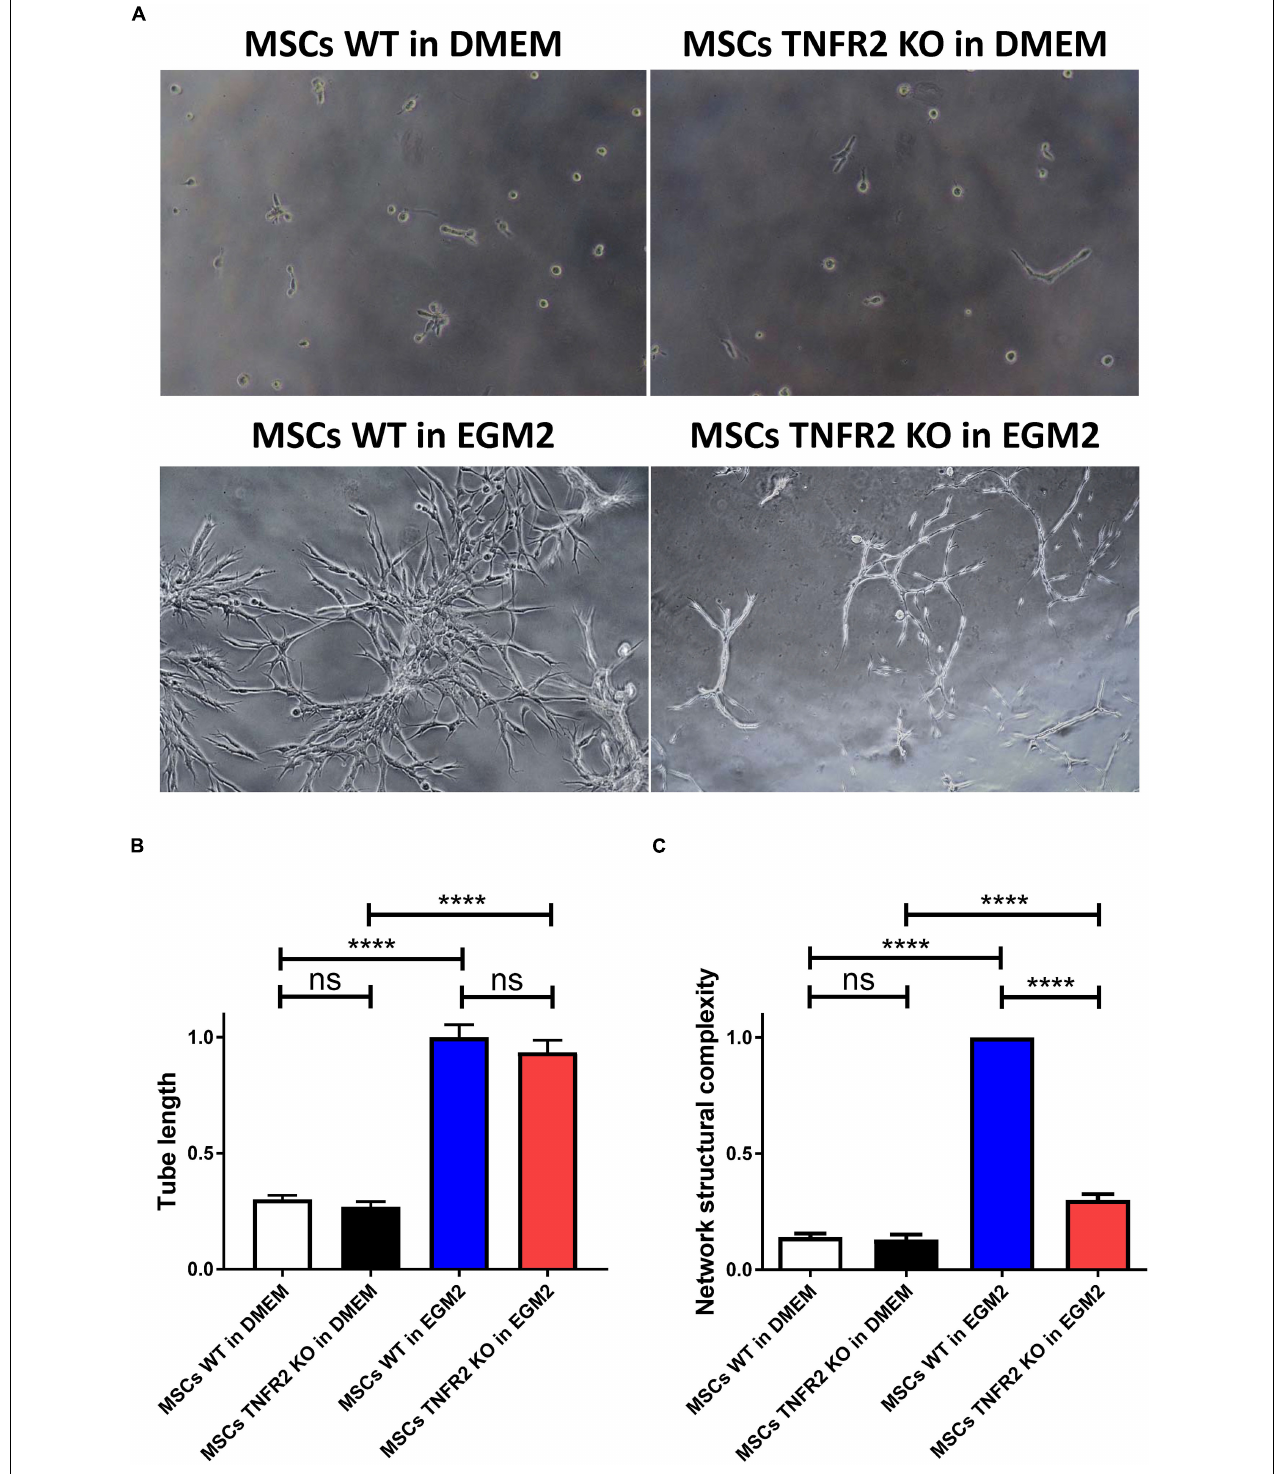
FIGURE 7 | The TNFR2 expression by mesenchymal stem cells (MSCs) is associated with their enhanced tube formation property. To evaluate the involvement of TNFR2 in MSC regenerative feature, wild-type (WT) and TNFR2 knockout (KO)-MSCs (P2 and P3) were cultured on Matrigel using either Dulbecco’s modified Eagle’s medium (DMEM) standard medium or EGM2 endothelial medium. (A) Pictures were taken every 2 h, using objectives 4 × and 10 × of the inverted microscope in phase-contrast mode. (B) The tube length and (C) network structural complexity of WT and TNFR2 KO-MSCs were further evaluated. Results are collected from three independent experiments ( n =